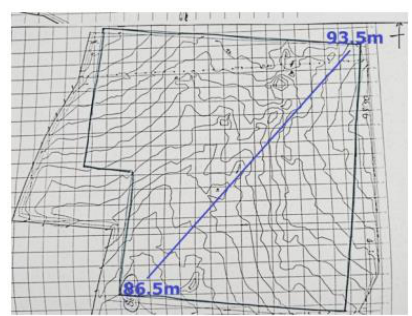
Figure 7. Terrain slope map before